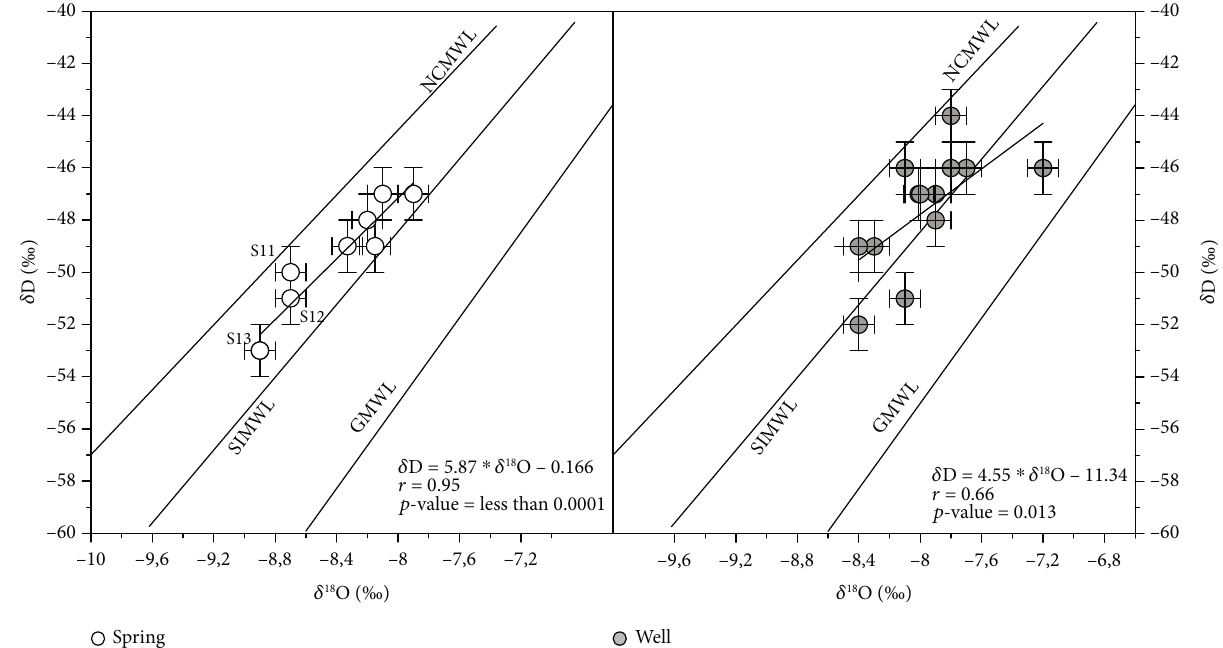
Figure 11: δ 18 O and δ D of the groundwater samples, as compared with meteoric water lines (Northern Calabria Meteoric Water Line (NCMWL), 6 : 22 ∗ δ 18 O + 5 : 21 , [46]; Southern Italy Meteoric Water Line (SIMWL), 6 : 7 ∗ δ 18 O + 5 : 2 , [47]; Global Meteoric Water Line (GMWL), δ D = 8 : 17 ∗ δ 18 O + 10 : 35 , [48]).The uncertainties 1 σ ( ± 0.1% for δ 18 O and ± 1% for δ D) were reported.